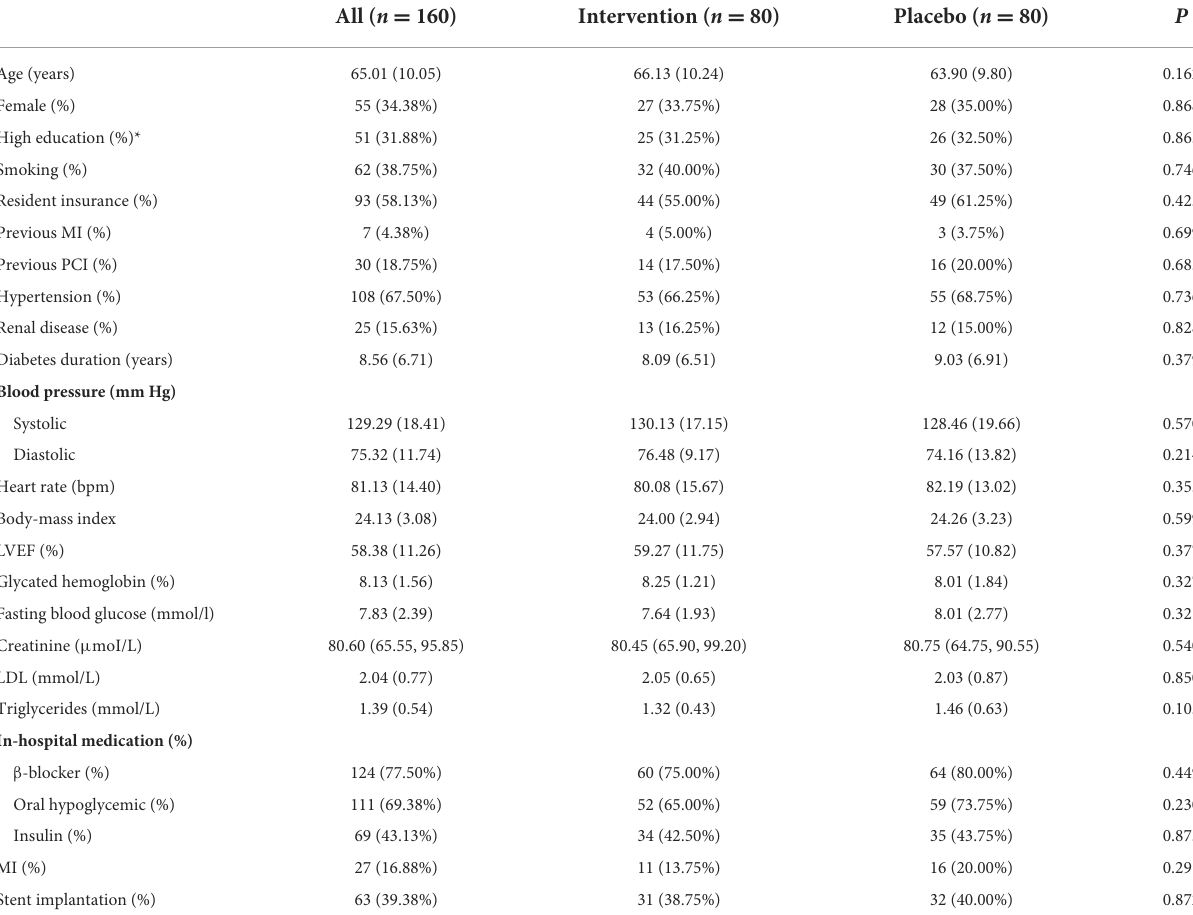
TABLE 1 Baseline participant